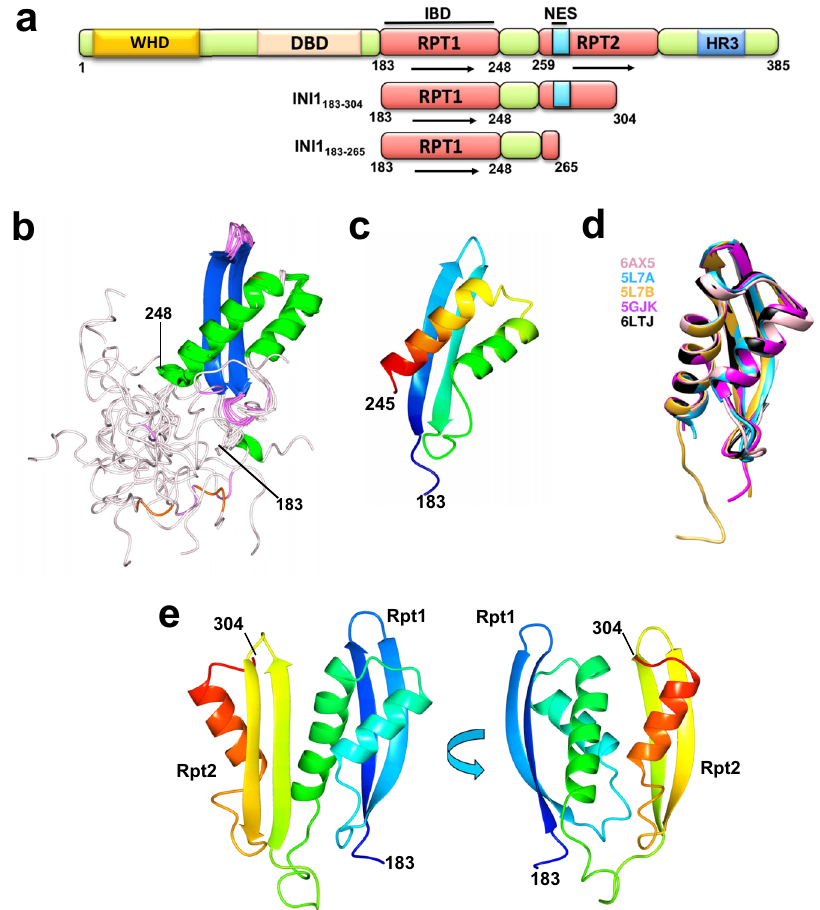
Fig. 1 NMR structure of Rpt1 + linker domains of INI1 and molecular modeling of IN binding Rpt1 + linker + Rpt2 fragment. a Schematic representation of various domains of INI1 and the inhibitory fragment S6 (WHD (in yellow) = Winged Helix DNA binding domain, DBD (in cream) = DNA binding domain; RPT (in red) = Repeat; NES (in turquoise) = Nuclear export signal; HR3 (in blue) = homology region 3; arrows represent repeats). b Superposition of the residues 183-265 of the 20 lowest-energy NMR structures of the INI1 Rpt1 + linker fragment. Note the disordered nature of the linker region (aa 250-265, shown in pale pink). The helices are in green and beta-sheet in blue. c A ribbon diagram (in rainbow colors) of a lowest energy representative structure of Rpt1 (aa183 – 245). d Superimposition of C-alpha atoms of fi ve different structures (6AX5 in pink, 57LA in turquoise, 5L7B in yellow, 5GJK in magenta, 6LTJ in black) showing alignment of the Rpt1 region (aa 183 – 248); e Ribbon diagram (in rainbow color) of a representative structure of INI1 183-304 modeled using Robetta based on the NMR structure 6AX5. PDB fi le of this model is included in the Supplementary Data